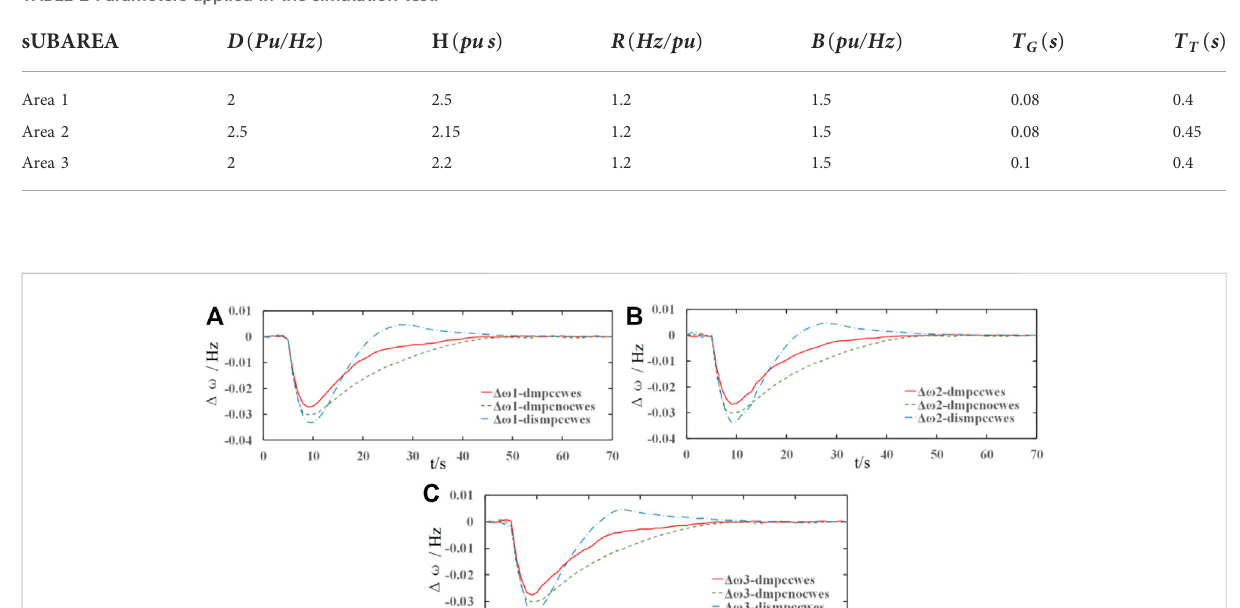
TABLE 2 Parameters applied in the simulation test.